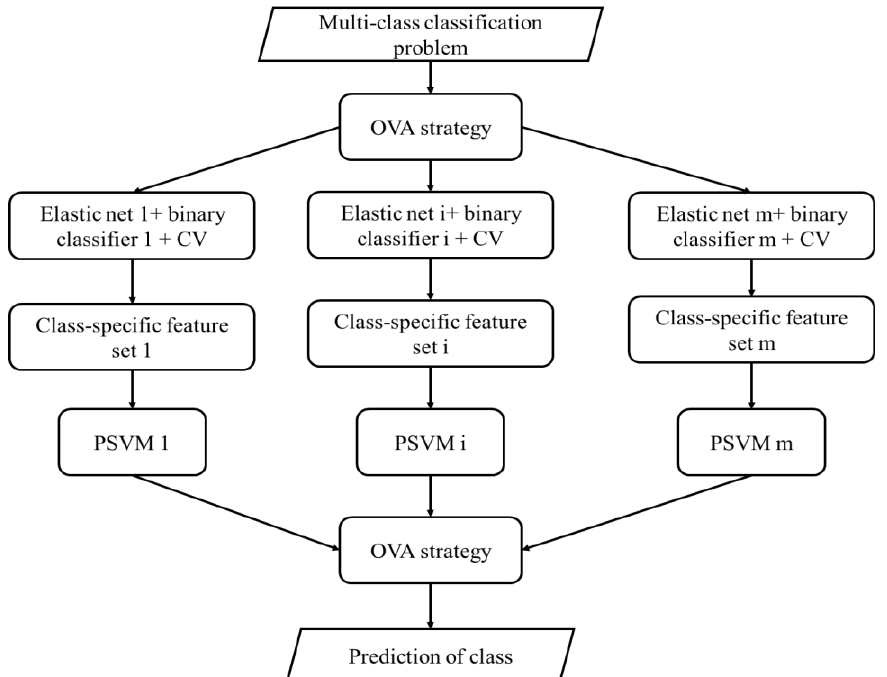
Figure 2. The flowchart of the proposed method.